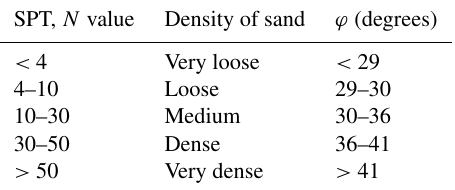
Table 1. Relationship between the angle of internal friction and SPT values (Peck,